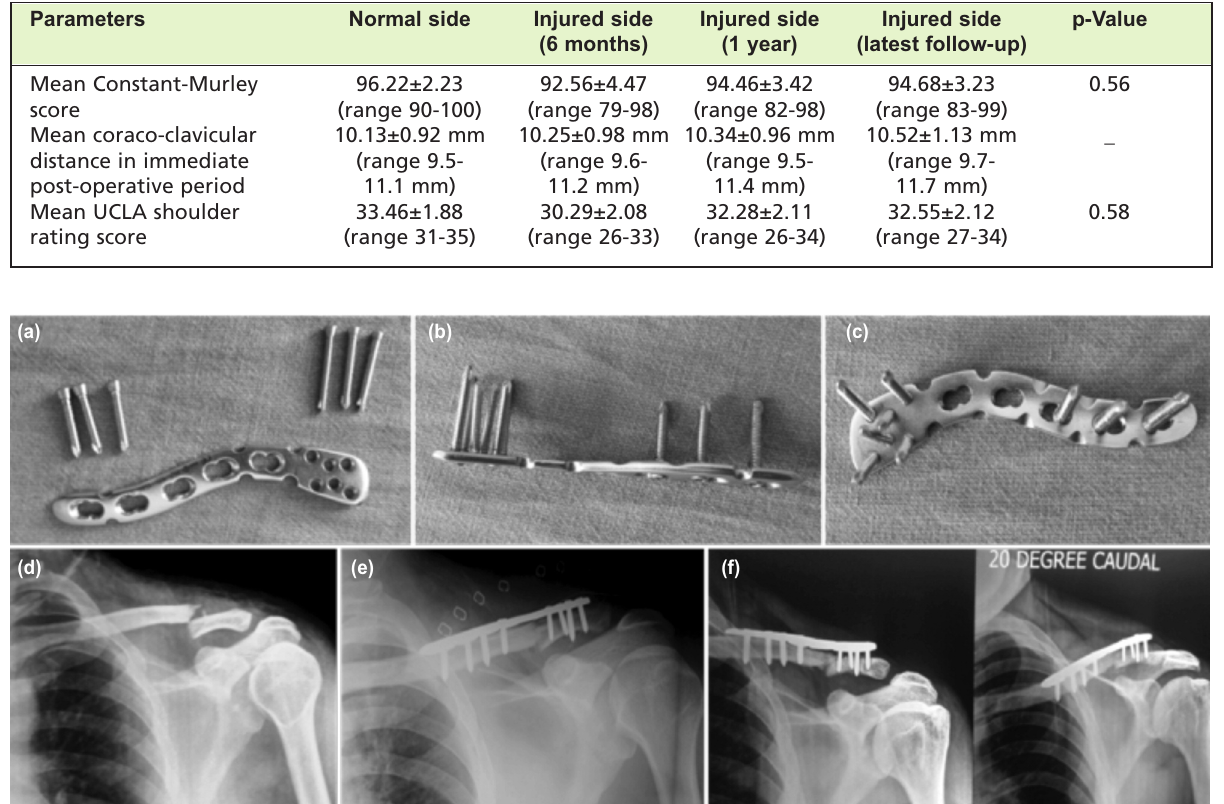
Constant-Murley Score, coraco-clavicular distance, UCLA Shoulder Rating Score in normal and injured sides Table I: